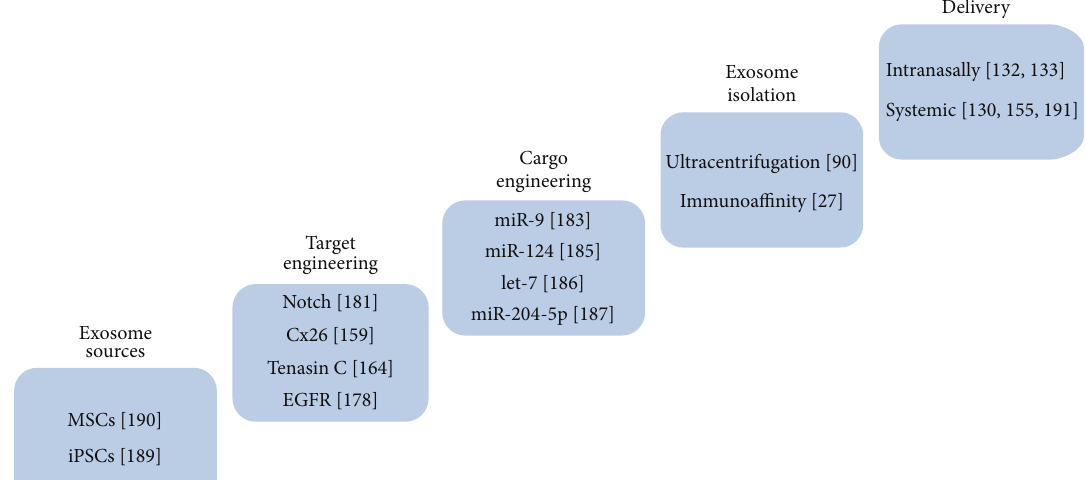
Figure 2: Schematic flowchart to develop a therapy based on the selective delivery of miRNAs mediated by engineered exosomes targeting neurogenic niches. Exosome sources box shows the cell culture type in which exosomes will be produced and harvested; target engineering box shows neurogenic niche-associated proteins that could be targeted with exosomes engineered to harbor a mimetic binding peptide in the outer surface of the vesicle; cargo engineering box shows several miRNAs that are known to modulate the fate of NPCs in the neurogenic niche; exosome isolation box shows two strategies to isolate the engineered exosomes from culture media: ultracentrifugation or immunoprecipitation of vesicles using antibodies against the extracellular domain of an exosome marker protein; delivery box shows two noninvasive CNS interventions: intranasal and systemic (by bloodstream) incorporation of engineered exosomes. References: